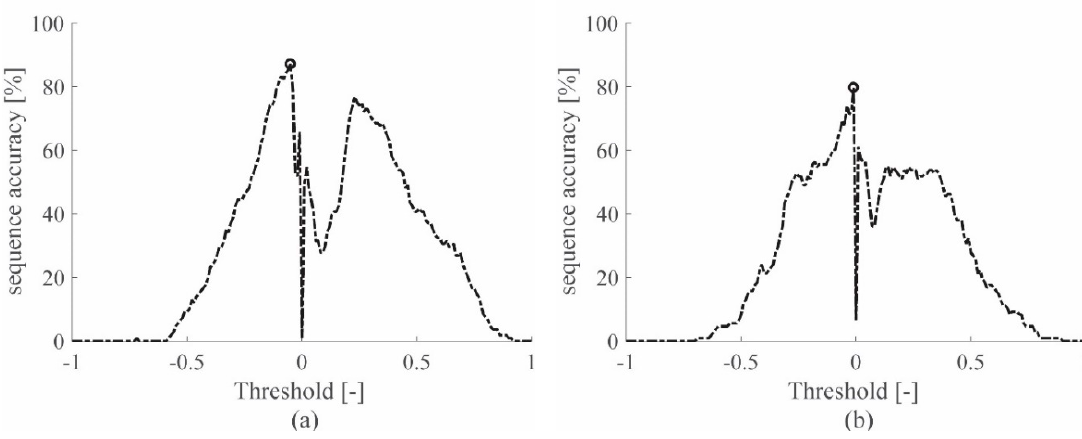
Figure 6. Sequence accuracy for the PZT signals on the aluminum plate ( a ) and the sandwich panel ( b ), when the 0–619 Hz or 0–1689 Hz filter is applied, respectively.